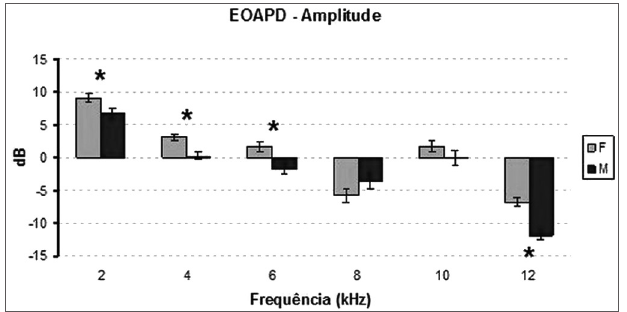
Figura 8. Média e desvio padrão das relações sinal/ruído das EOAPD registradas para cada orelha em cada frequência. OE: Orelha esquerda; OD: Orelha direita. Teste ANOVA, p = 0,499.